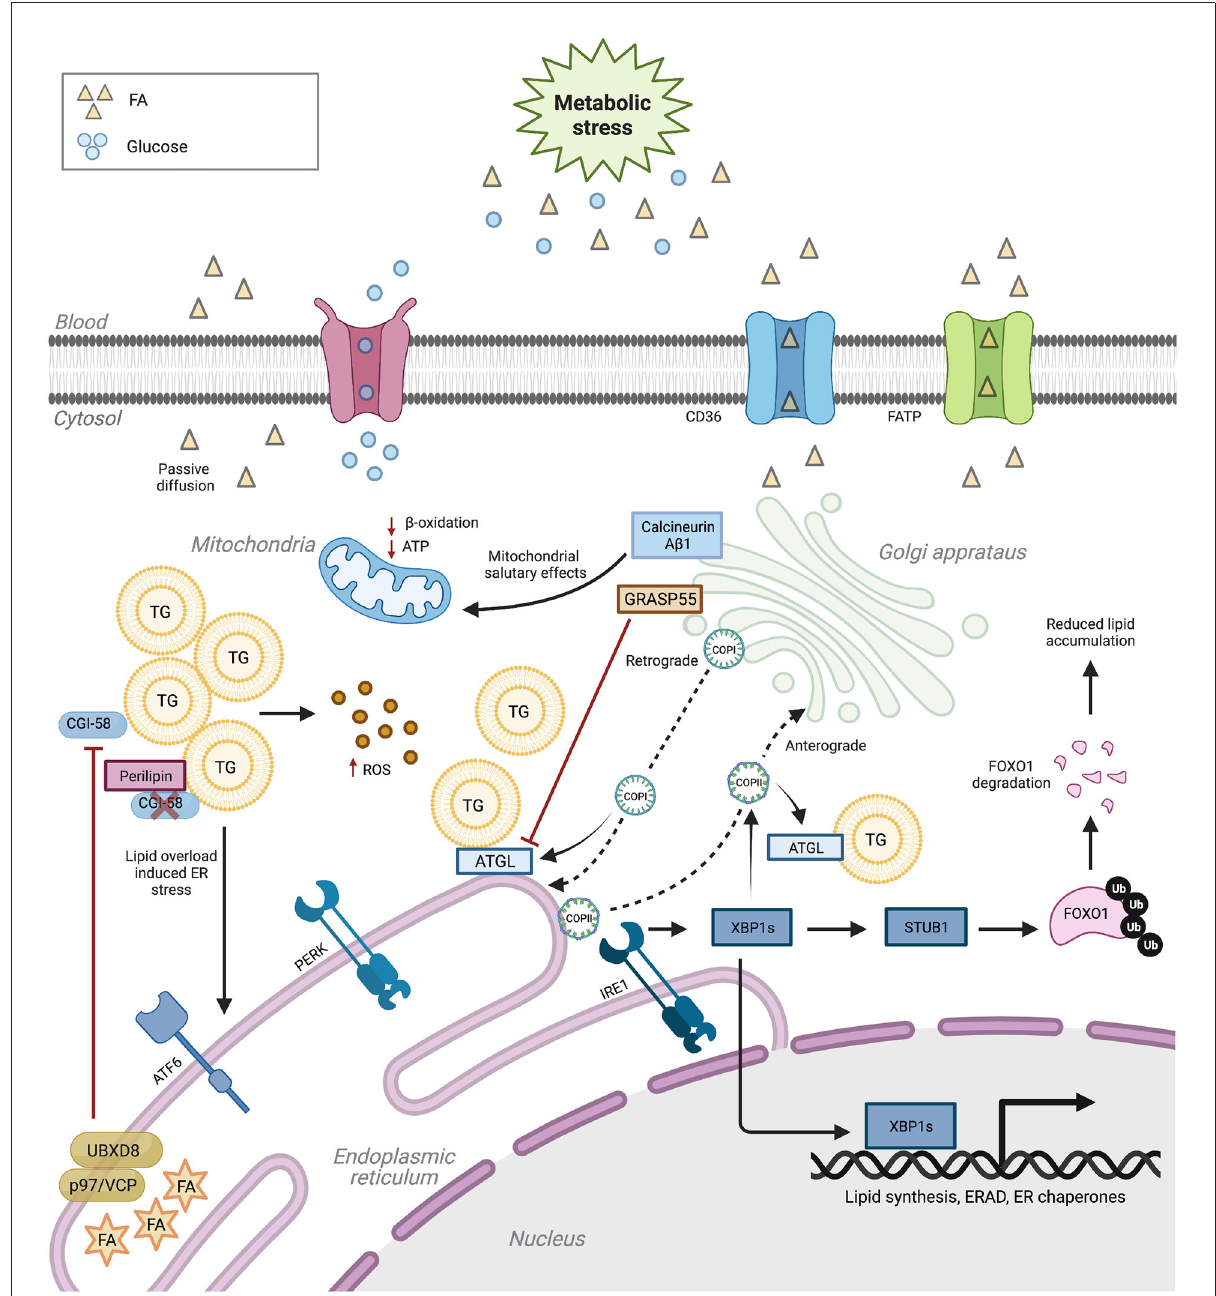
FIGURE1 ER and Golgi regulation of lipid metabolism. ER and Golgi functions are paramount for lipid metabolism. Aberrant ER and Golgi function induce cellular lipid disequilibrium. In turn, lipotoxicity negatively regulates the function of these two organelles. Upon metabolic stress, ER dysfunction inhibits TG degradation, eventually leading to oxidative stress. ER stress also reduces genes participating in ER function and lipid metabolism. Impaired Golgi proteins or COPI/II pathways damage lipogenesis and lipolysis balance. CD36 (cluster of differentiation 36), FATP (fatty acid transport protein), TG (triacylglycerol), FA (fatty acid), ROS (reactive oxygen species), ATGL (adipose triglyceride lipase), XBP1s (spliced X-box binding protein 1), FoxO1 (Forkhead box protein O1), COPI (coat protein complex I) and COPII (coat protein complex II). Created with